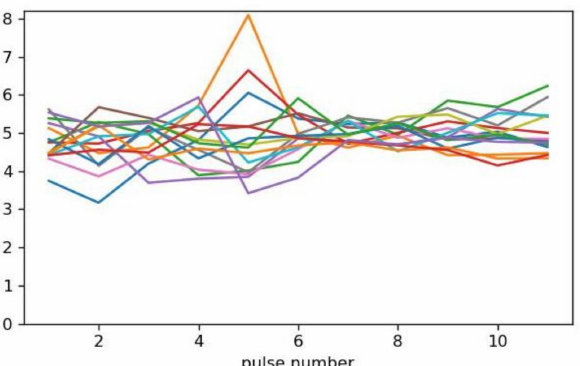
Figure 10. Calculated carbon content of the cathode as a function of the ablation pulse. Each graph is averaged over 4 depth